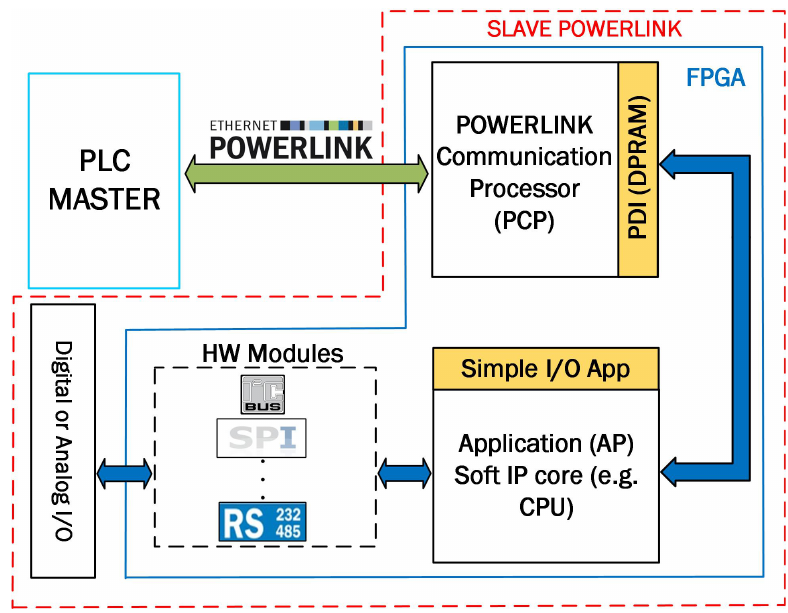
Figure 2. SPOF HW/SW Framework Architecture. POWERLINK slaves can be implemented both as stacks on the application processor or as a dedicated hardware communication block: this is schematically indicated with the POWERLINK Communication Processor